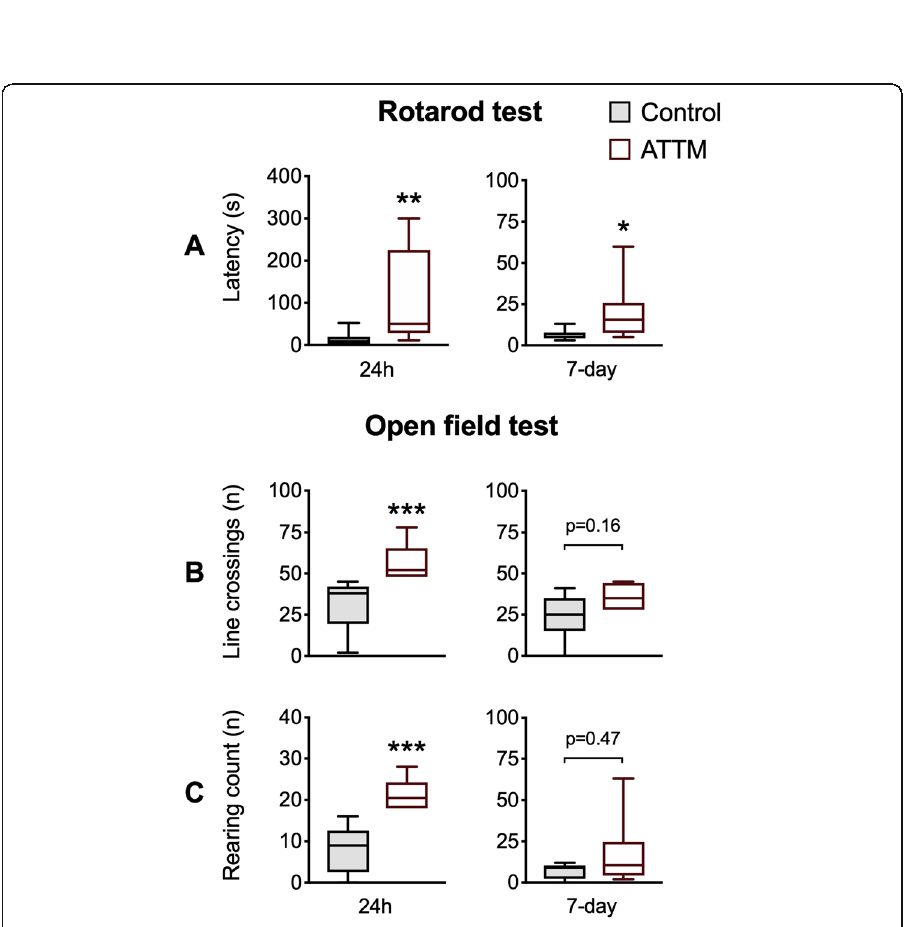
Fig. 4 Motor performance and locomotor activity. Motor performance assessed by rotarod is shown in panel a . Spontaneous line crossings and rearing counts using the open field test are shown in panels b and c , respectively. n = 8 – 9 per group. * p < 0.05, ** p < 0.01, *** p < 0.001 vs controls, unpaired T